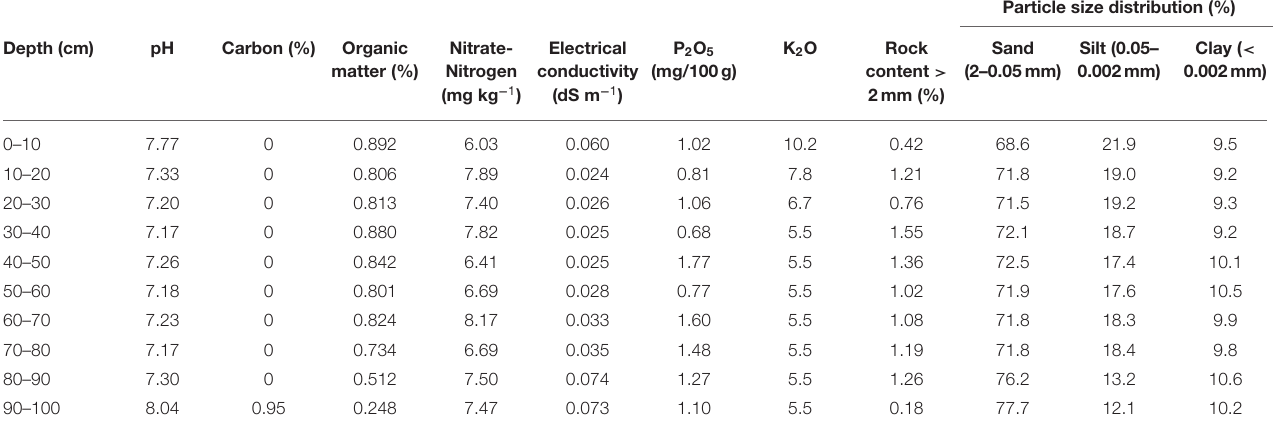
Particle size distribution